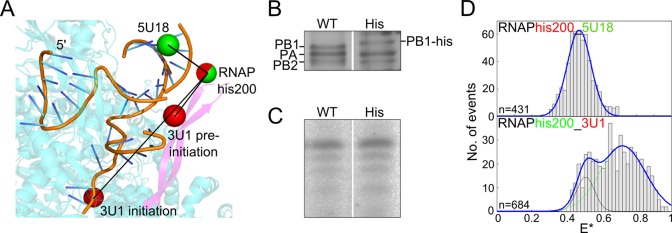
Fluorescent RNAP reveals multiple conformations of the 3′ terminus of the vRNA promoter. (A) Model of the influenza vRNA promoter and polymerase showing average dye positions. The 3′ vRNA is in orange and shows both the pre-initiation and initiation states, the polymerase is shown in blue, with the PB1 ß-ribbon highlighted in purple. A deca-histidine tag was inserted after residue 200 in the PB1 subunit (the additional histidine residues are not depicted in the figure; the red/green sphere represents the dye modelled on residue 200), while fluorescent dyes on the RNA are shown as green or red spheres. (B) Silver-stained polyacrylamide gel of wildtype (WT) and histidine-tagged (His) RNAP. (C) In vitro transcription assay showing that the histidine tag does not interfere with polymerase activity. (D) ATTO647N-labelled histidine-tagged polymerase (RNAPhis200) and vRNA promoter, labelled with a Cy3 dye at position 18 on the 5′ end, were analysed by single-molecule FRET spectroscopy of diffusing molecules (upper panel). Cy3-labelled histidine-tagged polymerase (RNAPhis200) and vRNA promoter, labelled with an ATTO647N dye at position 1 on the 3′ end, were analysed in a similar fashion (lower panel).